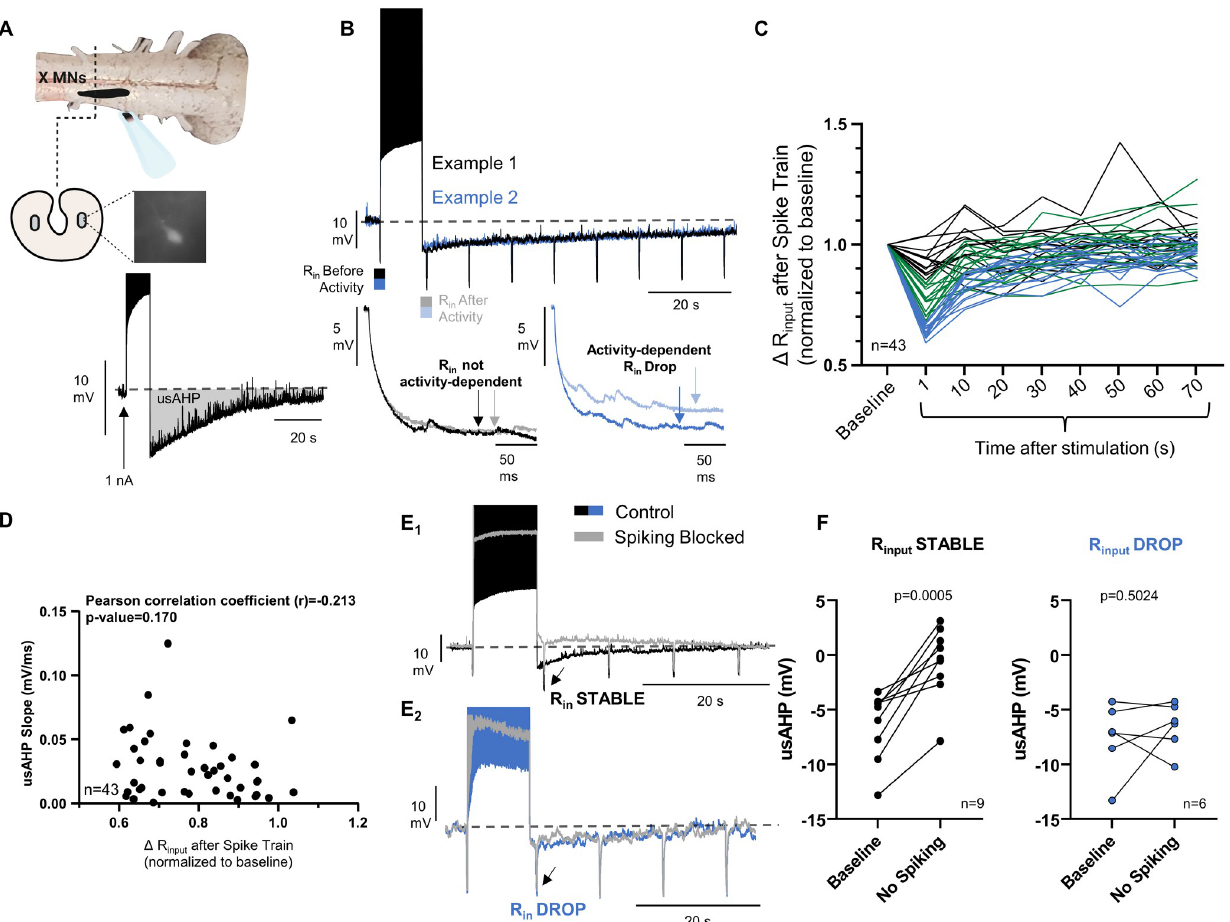
Fig 1. The usAHP involves multiple mechanisms driven by different activity signals. (A) Identified vagal motoneurons that innervate the glottal dilator exhibit short-term regulation of excitability following intense firing, termed the usAHP. (B) The usAHP is associated with variable R in changes across neurons, with 1 example showing largely stable R in (black/gray) and another with a decrease (blue). (C) R in during the usAHP reported as a relative change from baseline in n = 43 neurons following stimulation, color coded by no (black), modest (green), and large (blue) R in changes. (D) The usAHP does not correlate with size of the R in drop ( n = 43 neurons from N = 15 animals). (E) Different activity signals drive the usAHP in association with the change in R in . Neurons with stable R in have an usAHP driven by spiking, and usAHPs with the largest R in decreases persist without spiking. (F) Mean data showing the influence of spiking on the usAHP (paired t test). Stable R in ( n = 9 neurons from N = 2 animals) and R in decreases ( n = 6 neurons from N = 6 animals). The data underlying this figure can be found in S1